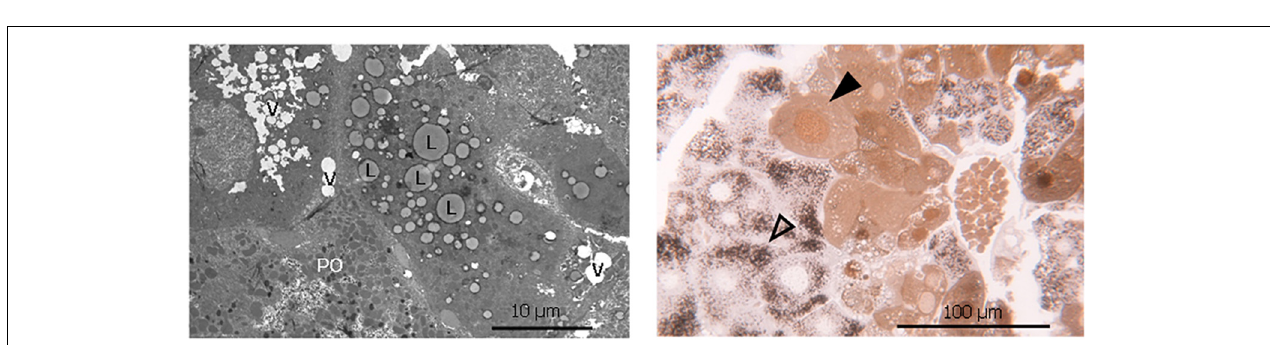
FIGURE 5 | Lipid accumulation, vacuolization and dual hepatocyte population in liver of phytol challenged PMP34 knockout mice. Left panel: Electron microscopic image of a liver section from an adult male phytol fed PMP34 knockout mouse, stained for catalase and contrast stained with uranyl acetate and lead citrate. Lipid accumulation (L) and vacuolization (V) are clearly visible in the hepatocyte lacking catalase positive peroxisomes, adjacent to a hepatocyte containing DAB-reactive peroxisomes (PO). Right panel: Light microscopic image of a semithin liver section from an adult male phytol fed PMP34 knockout mouse. A dual population of hepatocytes can be observed: aberrant hepatocytes, lacking DAB-reactive peroxisomes and containing cytoplasmic and nuclear catalase (closed arrowhead) are discernible adjacent to normal hepatocytes containing DAB-reactive peroxisomes (open